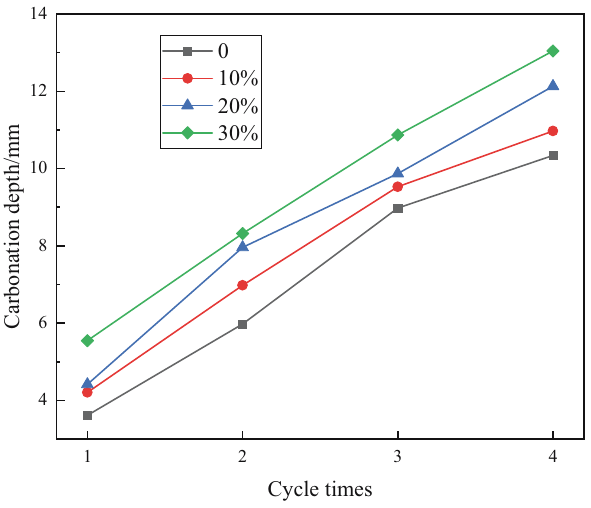
Figure 7: Curve of carbonation depth of fl y ash concrete [ 80 ]